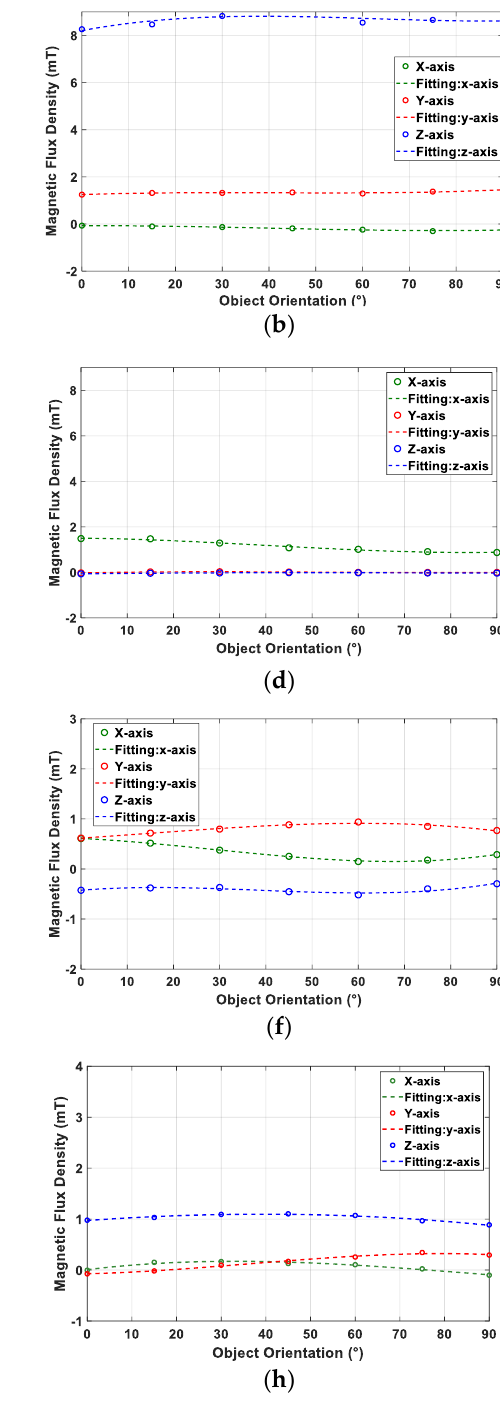
Figure 3. Changes in magnetic flux density (MFD) at different object orientations for each fingertip design: ( a ) Design I; ( b ) Design II; ( c ) Design III; ( d ) Design IV; ( e ) Design V; ( f ) Design VI; ( g ) Design VII; and ( h ) Design VIII.